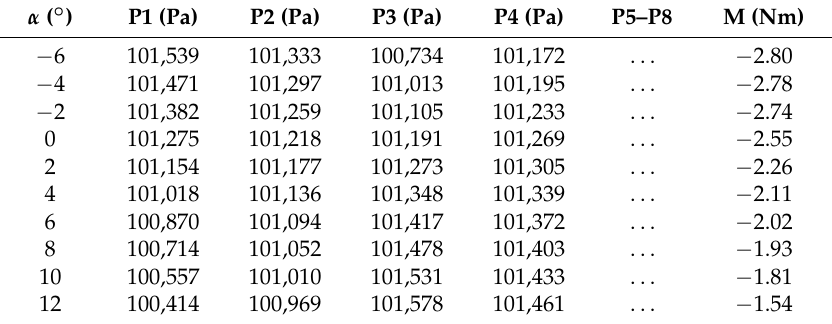
Table 2. Computational aerodynamic data samples: sampling rate of 2°.